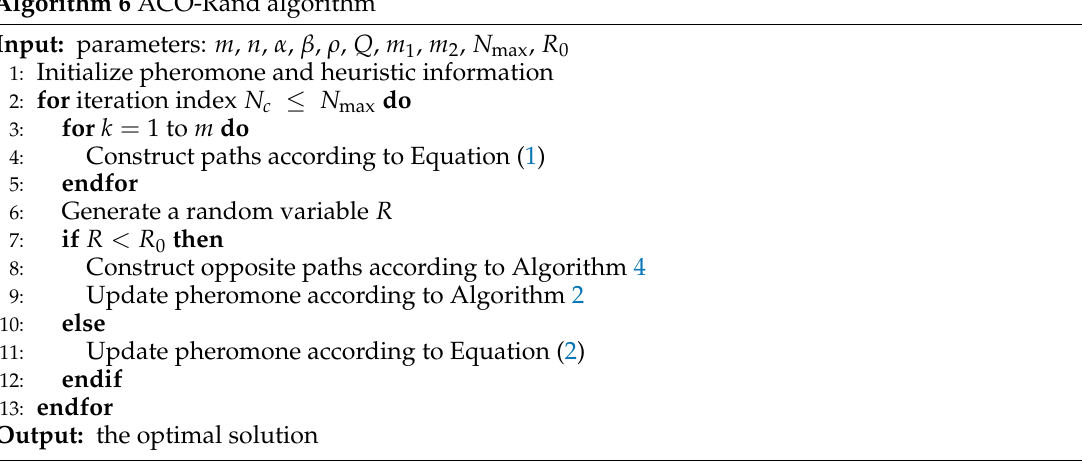
Algorithm 6 ACO-Rand